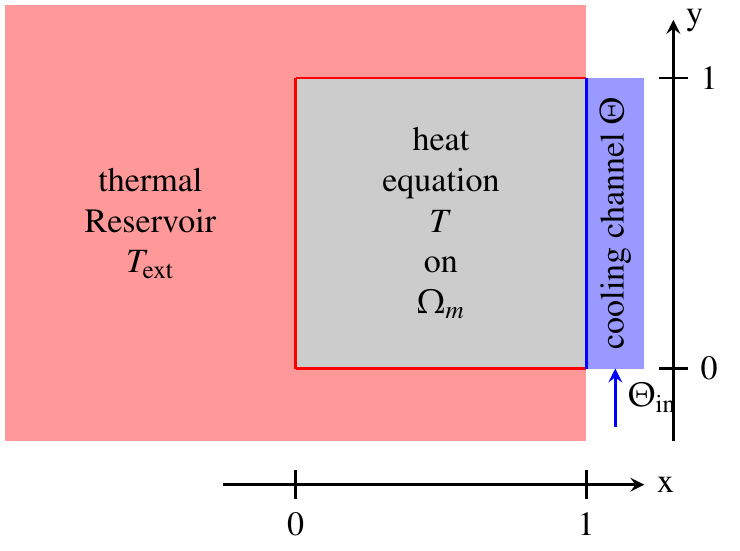
Figure 1. Schematic of the 2D model system with ∂ Ω ext marked as a red line and ∂ Ω c as a blue